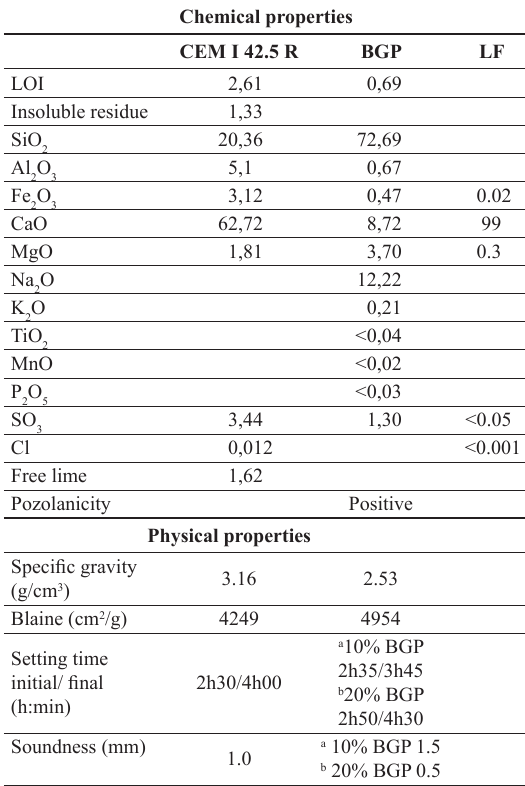
Table 1. Chemical and physical properties of cement, waste glass powder (BGP) and limestone filler (LF).